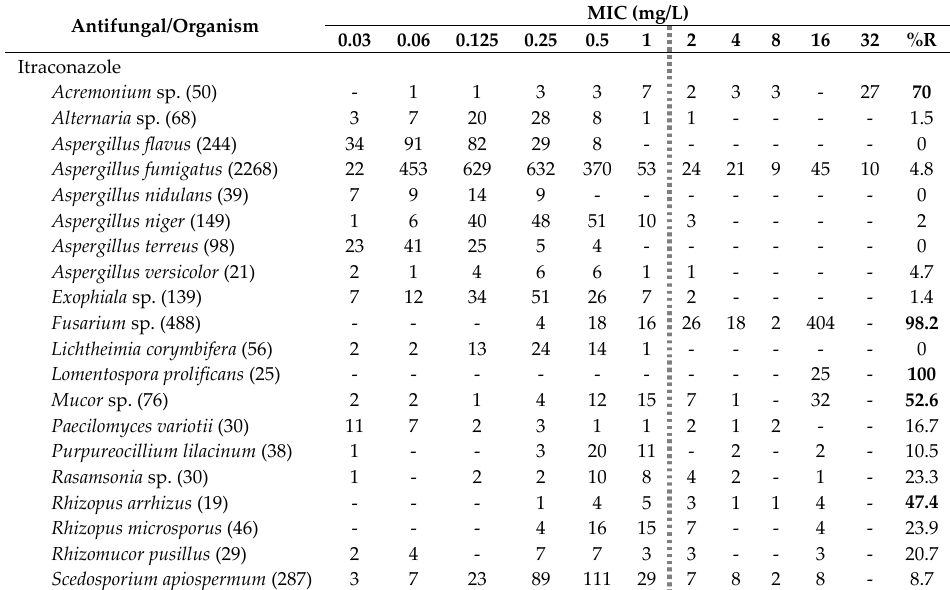
Table 2. MIC distributions for Iitraconazole. For presentation conventions, see Legend to Table 1.